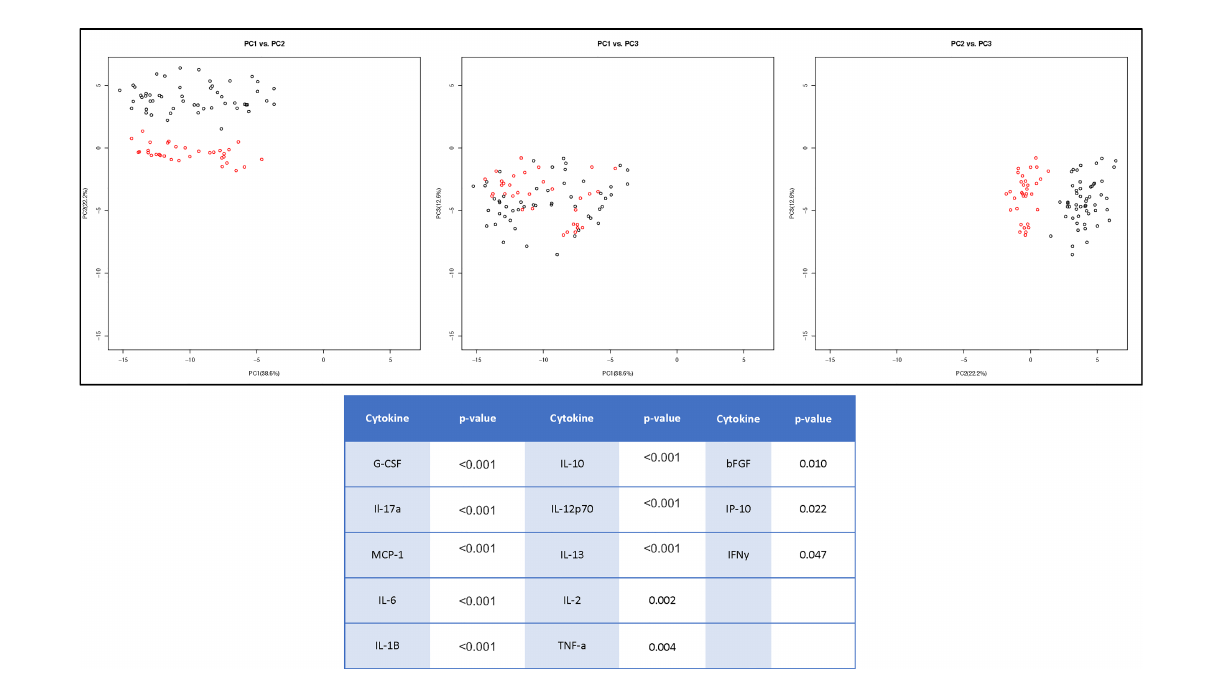
FIGURE 2 | Cluster Analysis of TMOA Patients Indicates Presence of Sub-Groups. Principal component analysis (n=83) of cytokine expression of patients at baseline timepoint indicates a two sub-groups of patients. Wilcoxon tests performed between the two clusters indicates 13 cytokines which are differentially expressed (p < 0.05, q < 0.1).